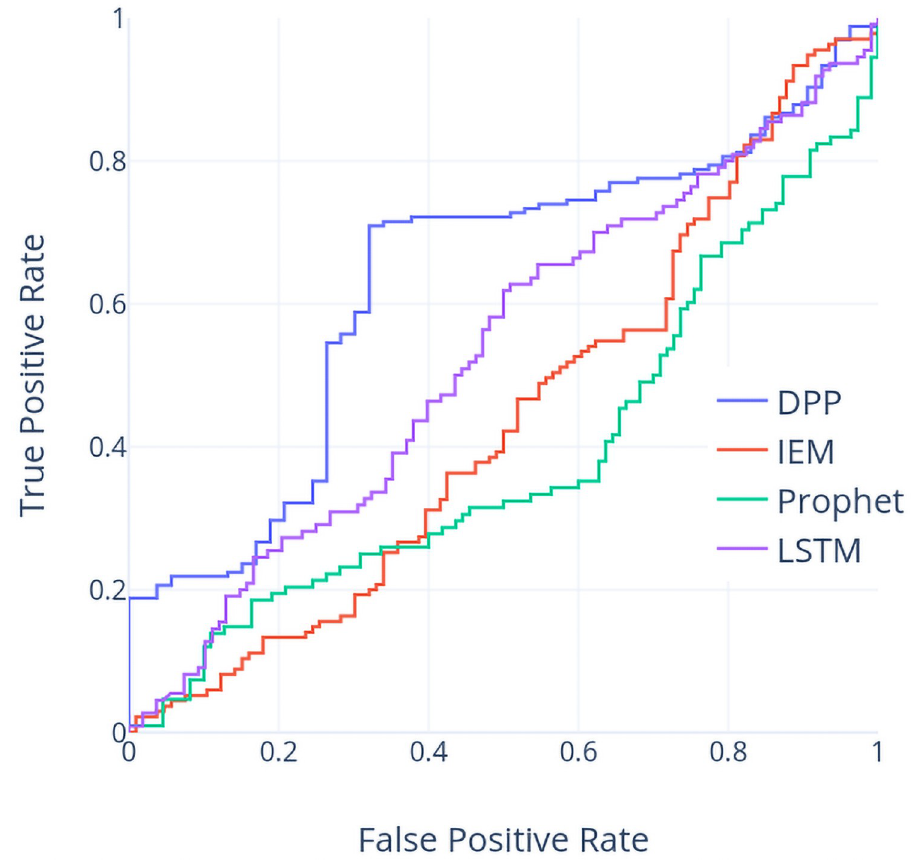
Fig 11. ROC curve (NI225